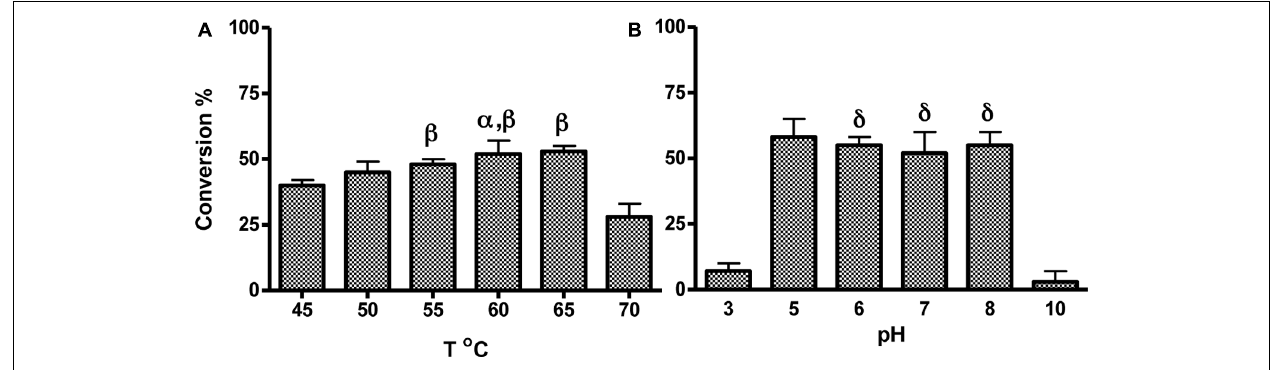
or pH buffers (B) . Error bars represent standard deviation from the mean of triplicate technical replicates. Significance indicated by: α p < 0.05 versus activity at 45 ◦ C, β p > 0.05 versus activity at 50 ◦ C, δ p > 0.05 versus activity at